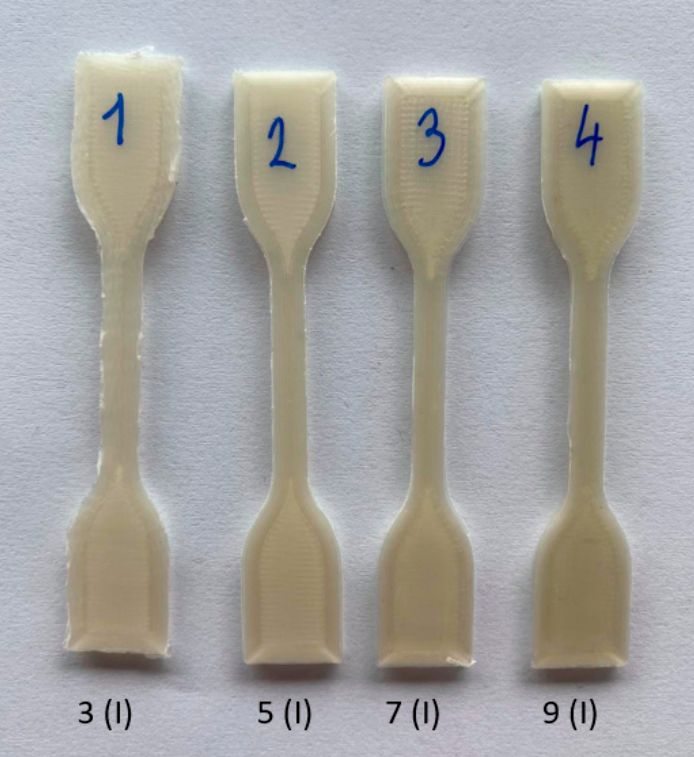
Figure 9. 3D printed samples after multiple processing (3rd, 5th, 7th, and 9th processing transition) of the industrial type sample, NONOILEN ® Fillamentum for NATURE.